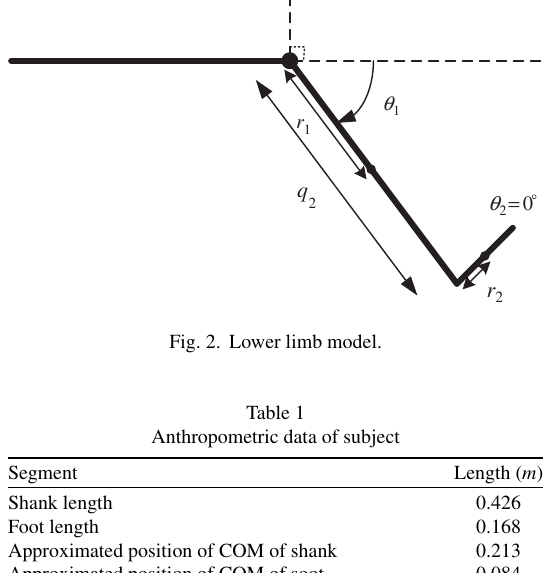
Table 1 Anthropometric data of